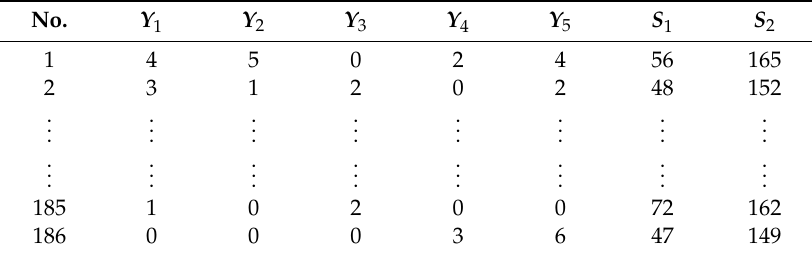
Table 12. Perturbed data using the CGADP method.